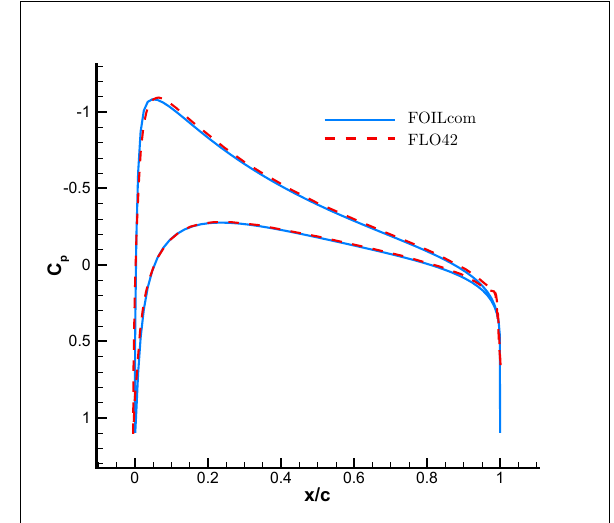
Figure 15. The pressure coefficient distribution. Comparison of FOILcom result and the one from FLO42 [24].